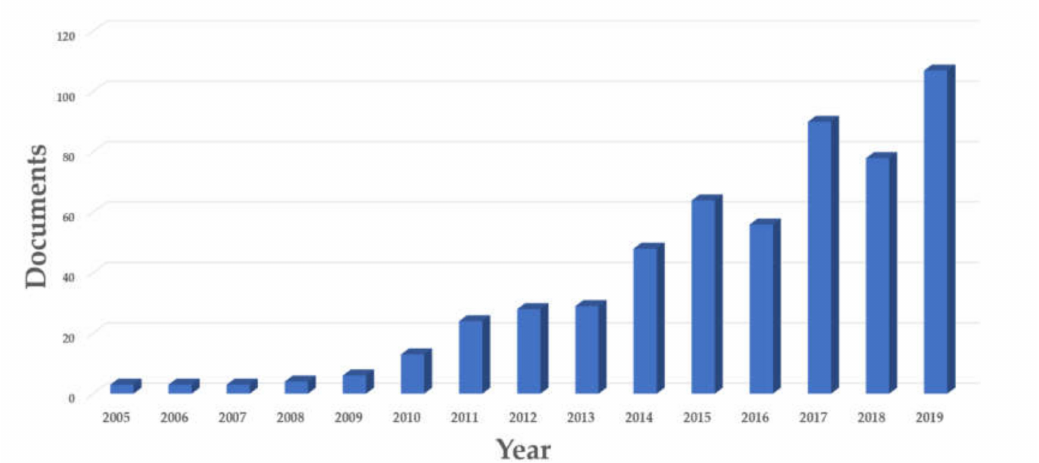
Figure 3. BIM’s success over time as the number of relevant Scopus publications per annum for the energy e ffi ciency